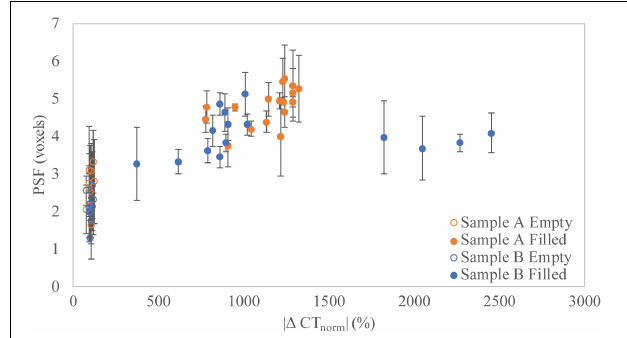
FIGURE 6 | Relationship between PSF size ( r PSF , voxels) versus attenuation difference (| (cid:49) CT norm |%) for individual traverses of empty and filled pores in both